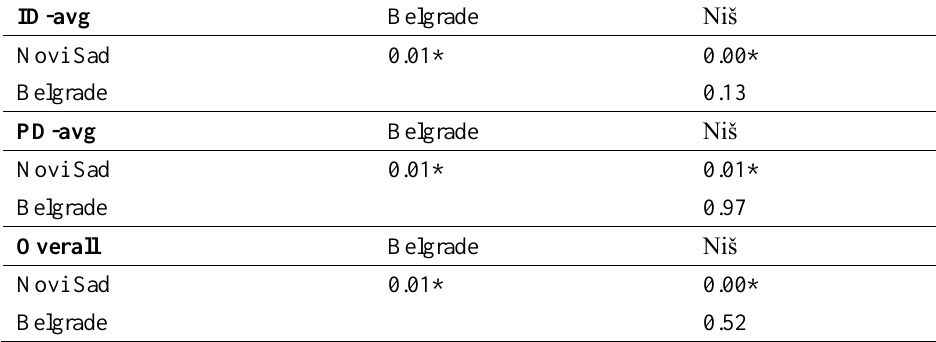
TABLE 3 Significant results of LSD post hoc test for ID, PD and Overall